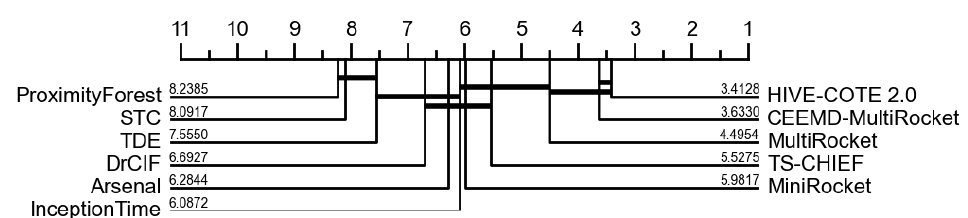
Figure 3. Mean rank of CEEMD-MultiRocket in terms of accuracy over 30 resamples of 109 datasets from the UCR time series repository, against 10 other SOTA